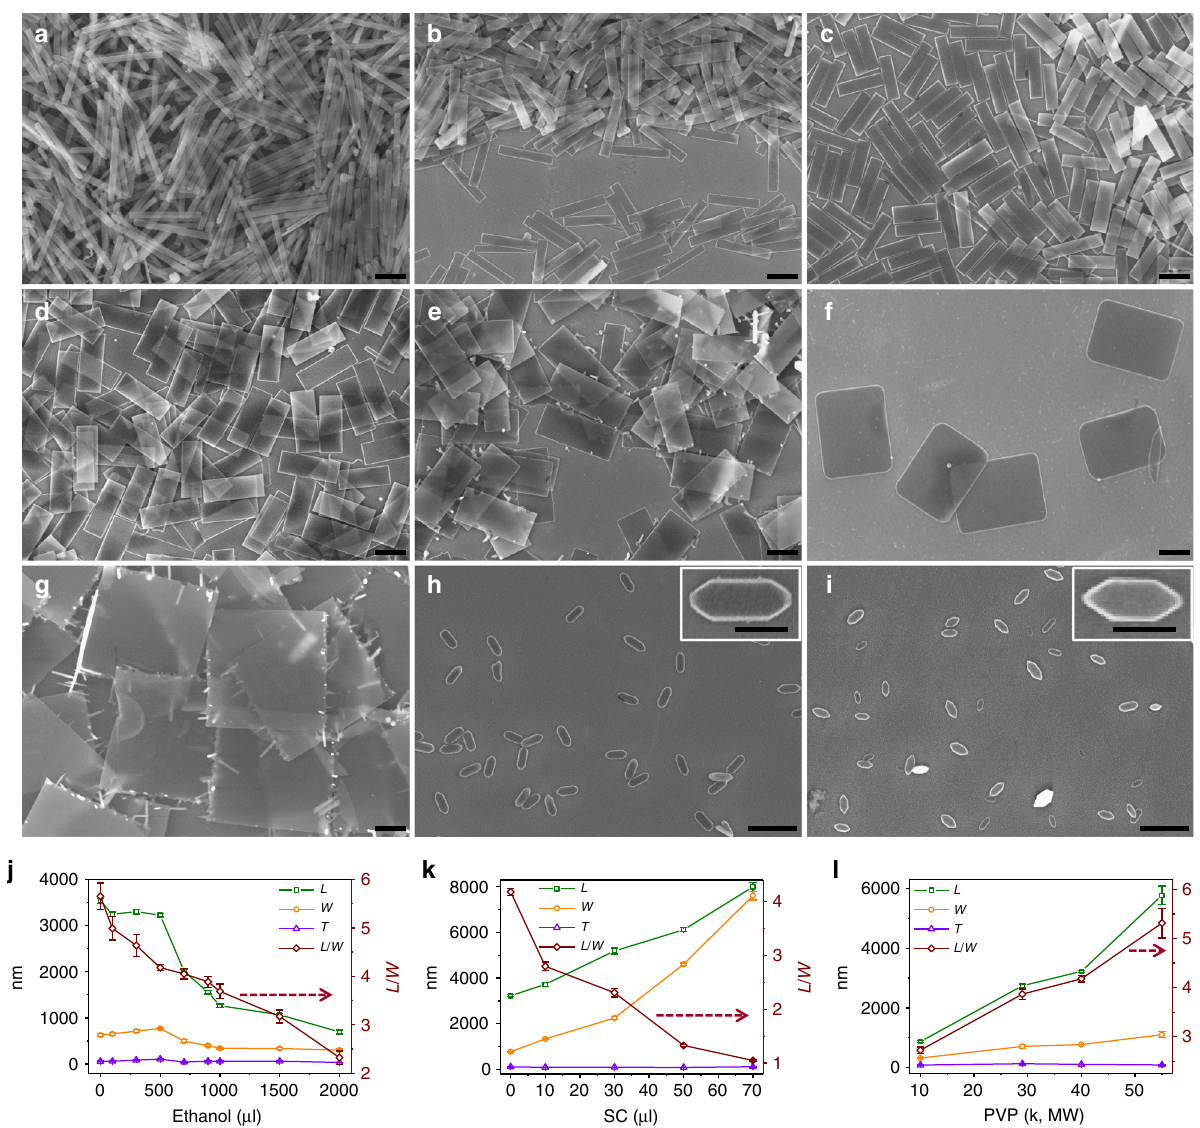
Fig. 3 Representative SEM images of colloidal cuboids with different shapes. Cuboidal particles in c were synthesized with ethanol (500 μ l), Fe 2 (SO 4 ) 3 (40 mg ml − 1 , 140 μ l), NH 3 (60 μ l), SC (0 μ l), and TEOS (50 μ l). Using synthetic condition for c as reference, the adjustments for synthesizing other cuboidal particles were: a NH 3 (200 μ l), b ethanol (0 μ l), d SC (0.18 M, 10 μ l), e SC (0.18 M, 30 μ l), f SC (0.18 M, 50 μ l), g SC (0.18 M, 70 μ l), h ethanol (1800 μ l), and i ethanol (2000 μ l), while other parameters were the same. Scale bars, 2 μ m in ( a – i ) and 500 nm in insets of ( h , i ). j – l The dependency of colloidal geometry on the amount of ( j ) ethanol, k SC, and l MW of PVP. Error bars in ( j – l ) represent standard deviations by measuring 200 samples for each